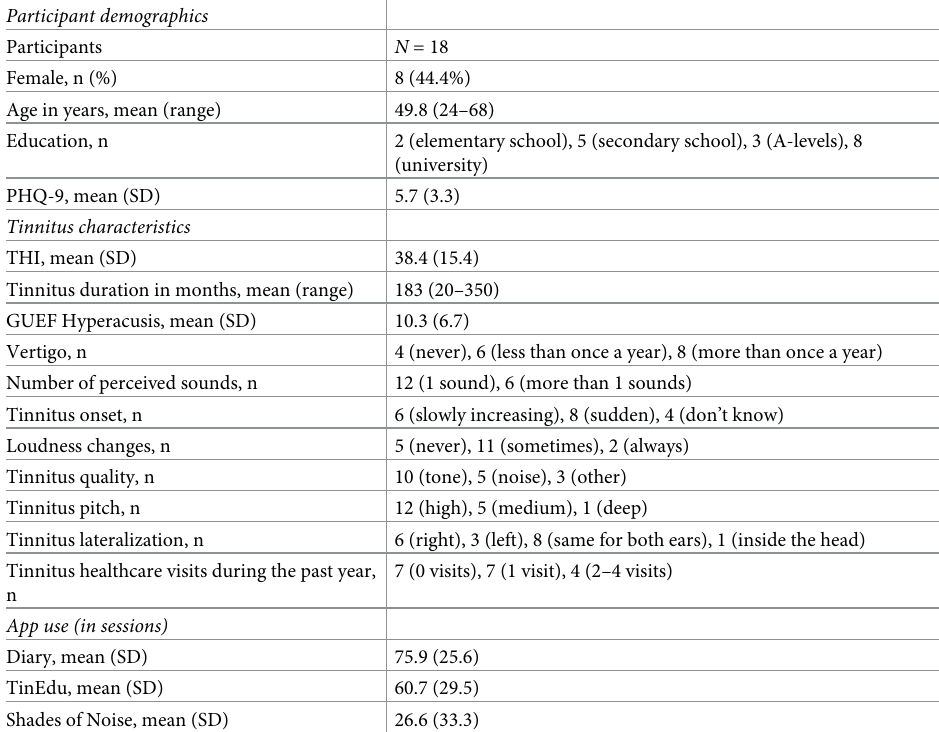
Table 1. Participant demographics, tinnitus characteristics and app